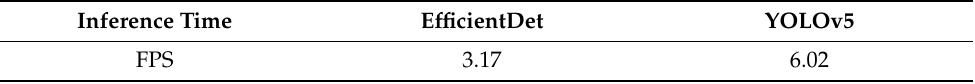
Table 1. The FPS for both EfficientDet and YOLOv5 on an image with resolution 1600 × 1600